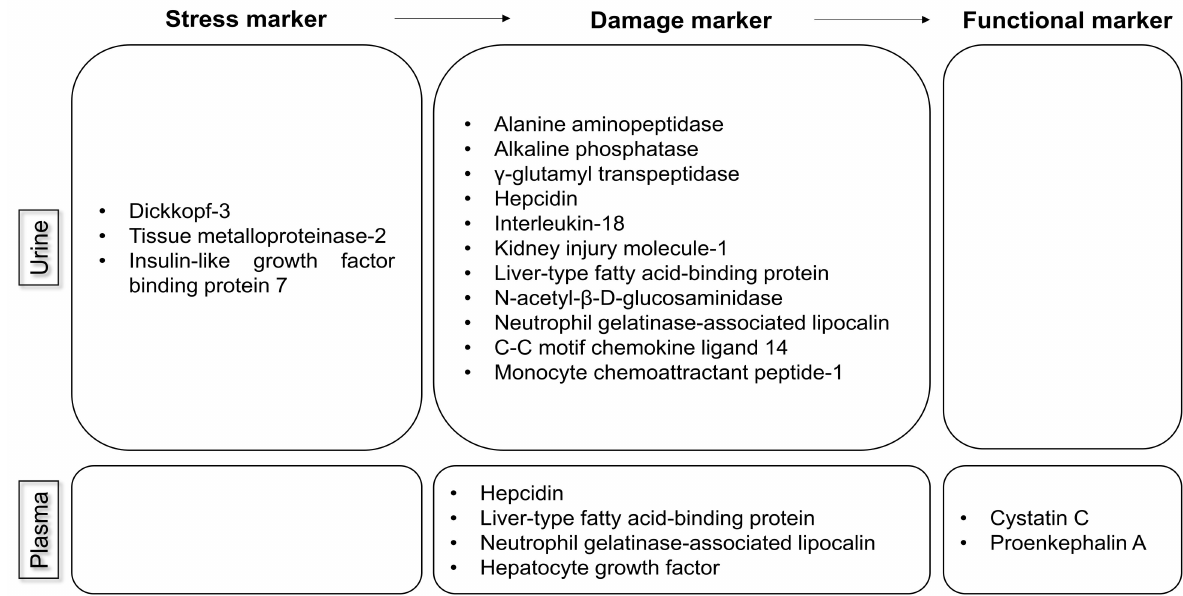
Figure 1. Three types of biomarkers of AKI from urine and